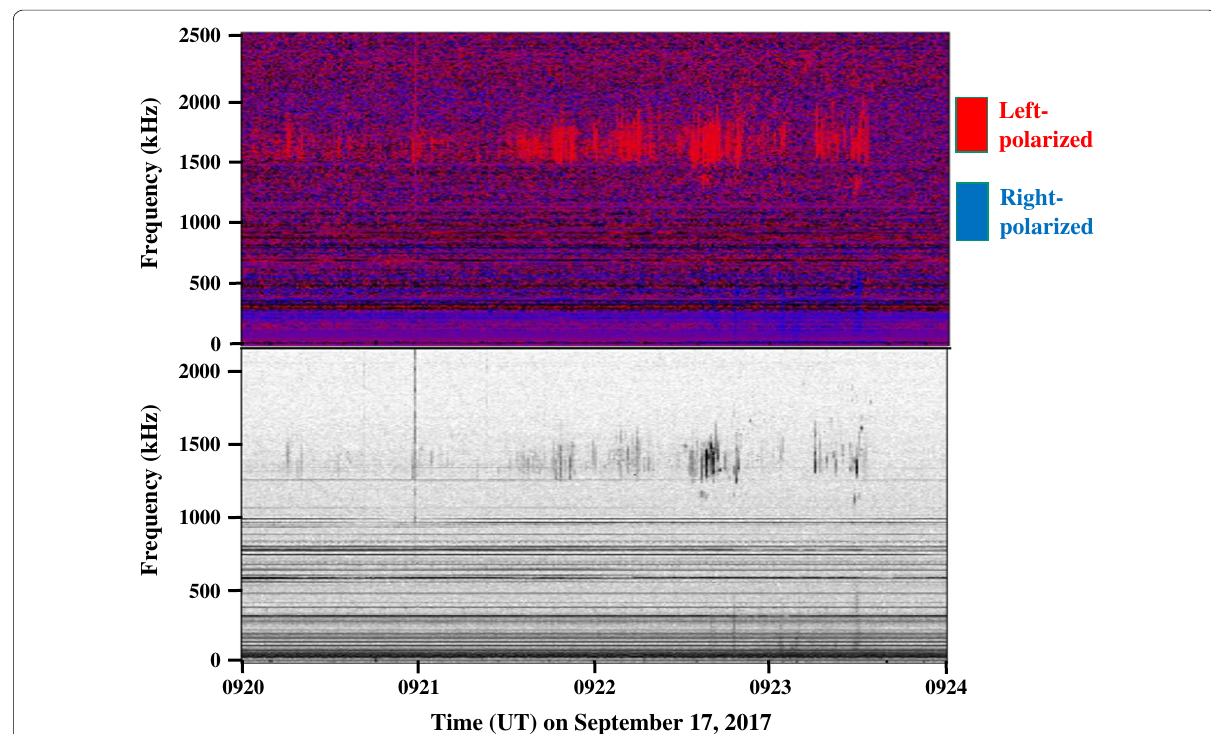
Fig. 3 Spectrograms of intensity (bottom panel) and polarization (top panel) of MFB emission observed at Toolik Lake on September 17, 2017, confirming the result of Fig. 2 concerning polarization of the component of MFB below 1.5 MHz